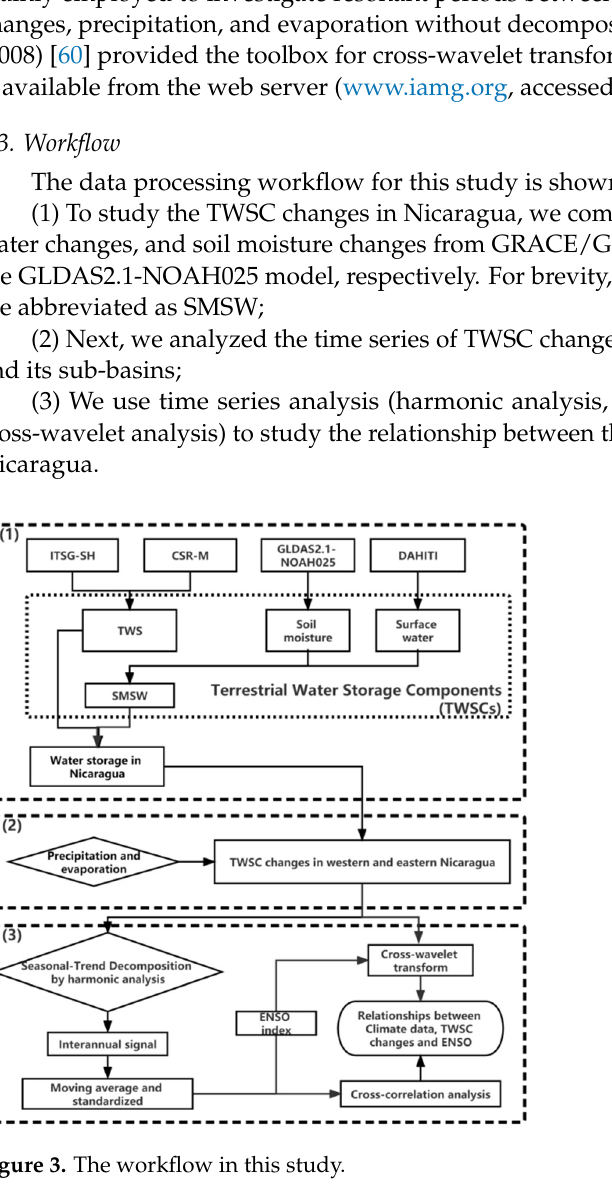
Figure 3. The workflow in this study.